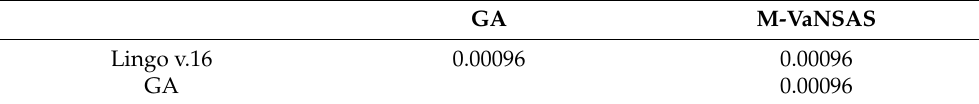
Table 13. p -value of the statistical test using Wilcoxon signed-rank test of data given in Table 11. GA